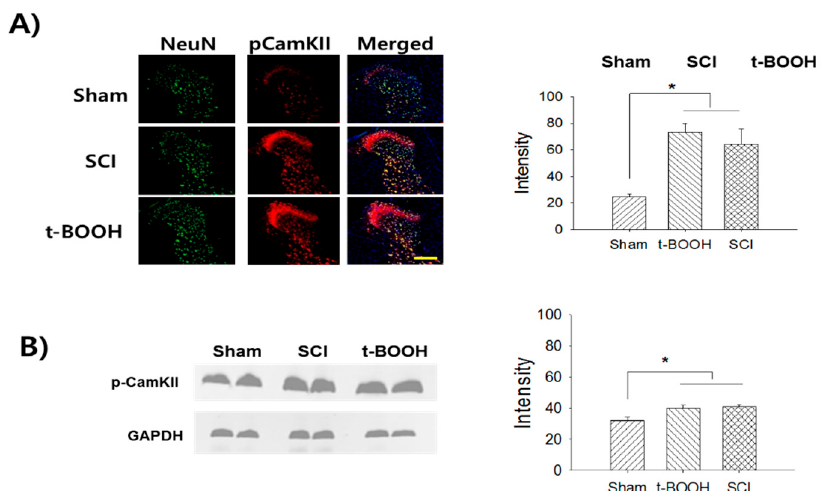
Figure 2. The contribution of ionotropic glutamate receptors on WDR neuronal firing rates after SCI. ( A ) The treatment of t-BOOH does not show significant changes in the expression of AMPA (GluR1 and GluR2/3) and NMDA (NR2A and NR2B) receptors, whereas the SCI group shows sig- nificant increases of GluR1, NR2A, and NR2B expression. Scale bar: 300 μ m. ( B ) The treatment of glutamate (20 ug) does not show significant changes of superoxide production. Scale bar: 50 μ m. ( C ) The treatment of NBQX (1 μ g) and MK801 (50 μ g) significantly attenuate WDR neuronal firing rates compared to SCI and vehicle groups (* p < 0.05).